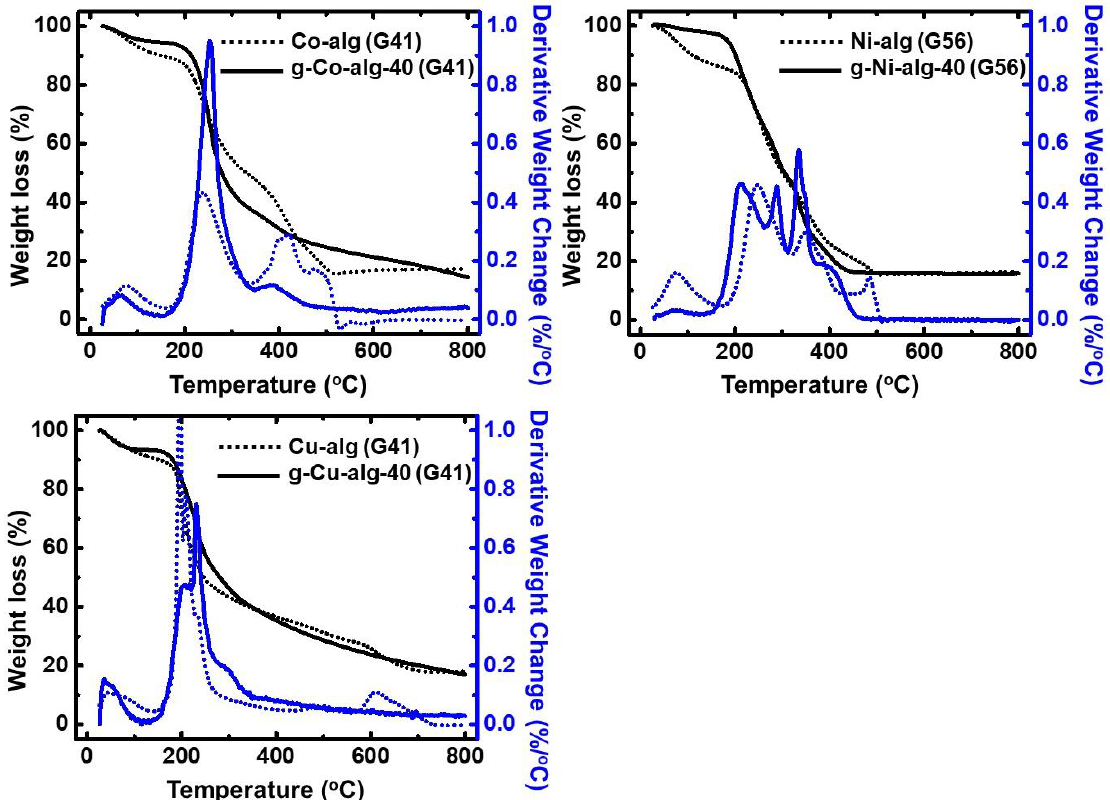
Figure 5. TGA (black lines) and DTG (blue lines) curves of M-alginate and g-M-alginate aerogels, as indicated.